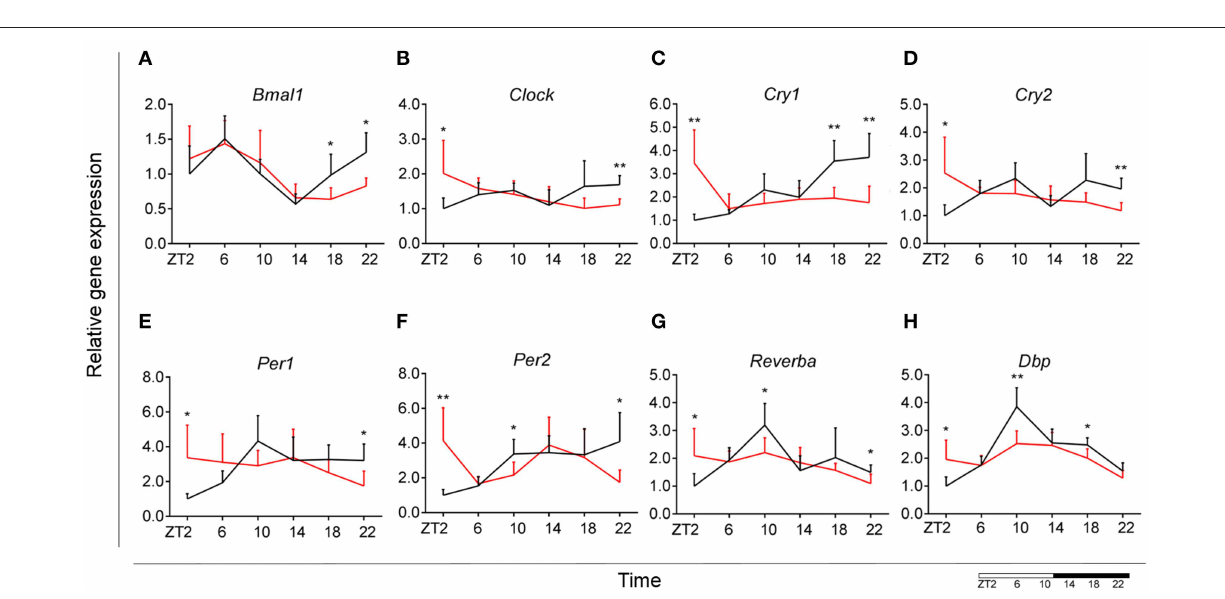
FIGURE 3 | Microglial circadian clock system in HFD-fed and control animals. Relative gene expression of circadian genes Bmal1 (A) , Clock (B) , Cry1 (C) , Cry2 (D) , Per1 (E) , Per2 (F) , Reverba (G), and Dbp (H) in HFD-fed rats (red) compared to Chow-fed controls (black). Data are presented as means ± SEM. Statistical significance was determined using Two-way ANOVA effects for Interaction , Diet, and Time (ZT); Student t -test is used for diet effect within a separate time point (* p < 0.05; ** p < 0.01). Scale (bottom right) represents light (ZT0-12) and dark (ZT12-24)